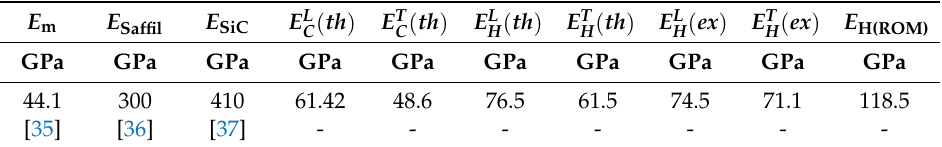
( ex ) . Calculated moduli values for Mg + Saffil in the L direction H ( th ) , and theoretical values of the hybrid moduli in C